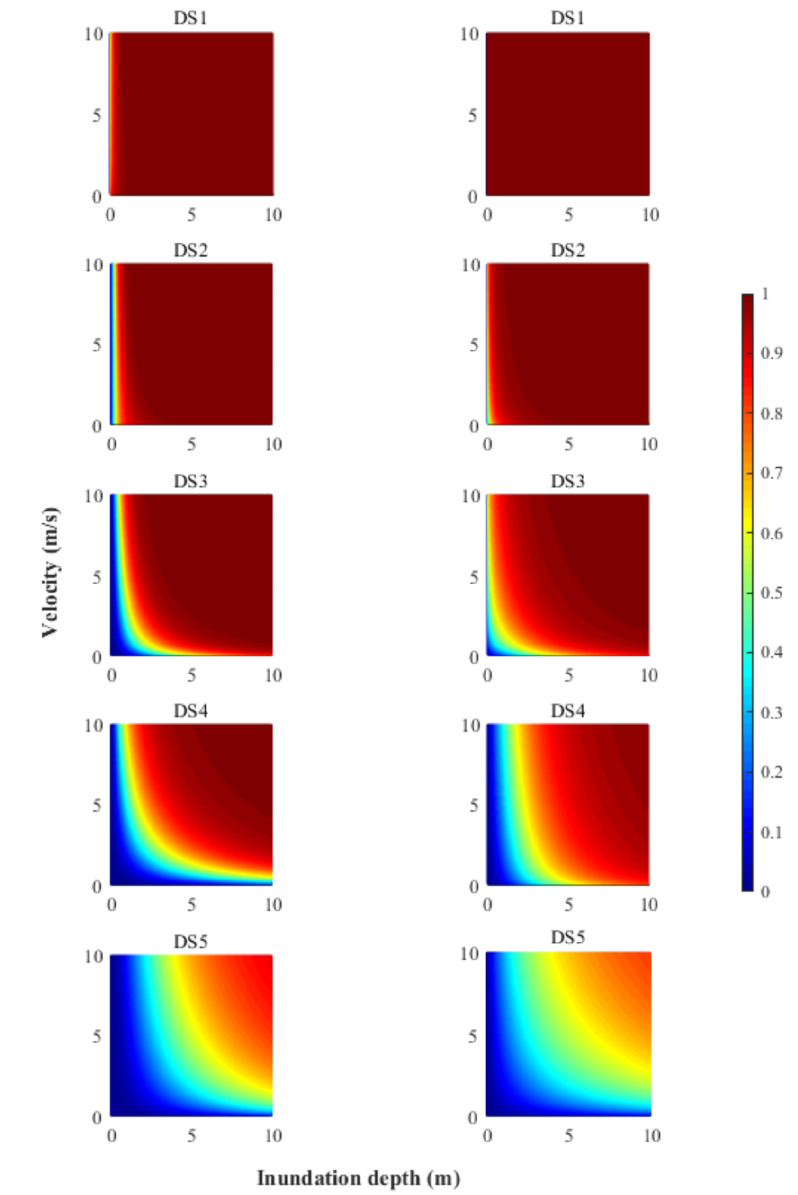
Figure 3. Fragility surfaces considering flow velocity for RC structures (on the left for plain coast and on the right for ria